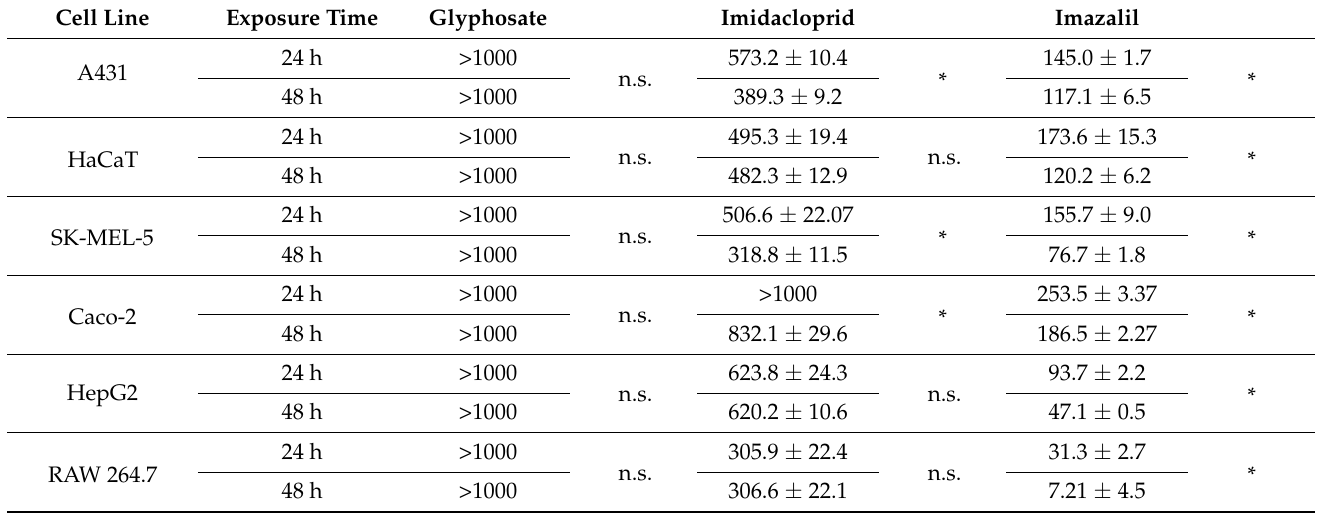
Table 1. IC 50 values (in µ M) of the tested cell lines exposed to glyphosate, imidacloprid and